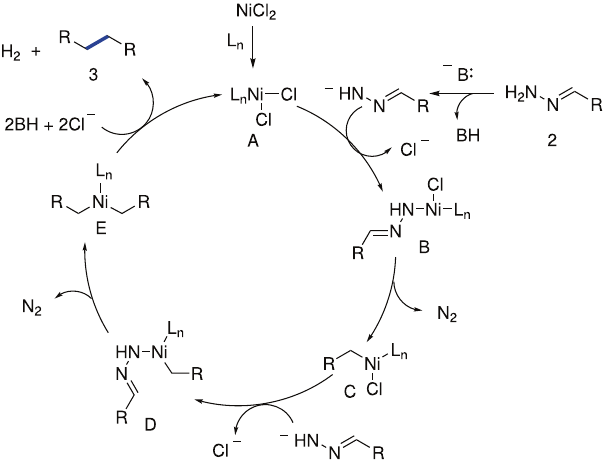
Fig. 5 Proposed mechanism. Possible reaction mechanism of deoxygenative homo-coupling of aldehydes/ ketones. L n means